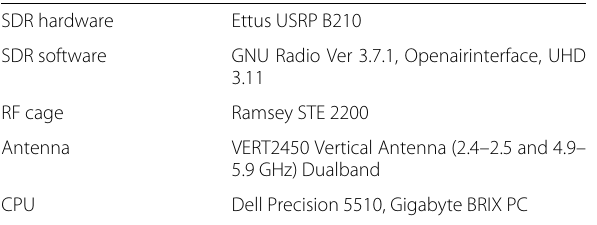
the GNU Radio WiFi receiver to output LLRs as we have to perform LLR scaling for all our single- antenna interference mitigating methods. In the next step, we scaled the LLRs with their corresponding LNV